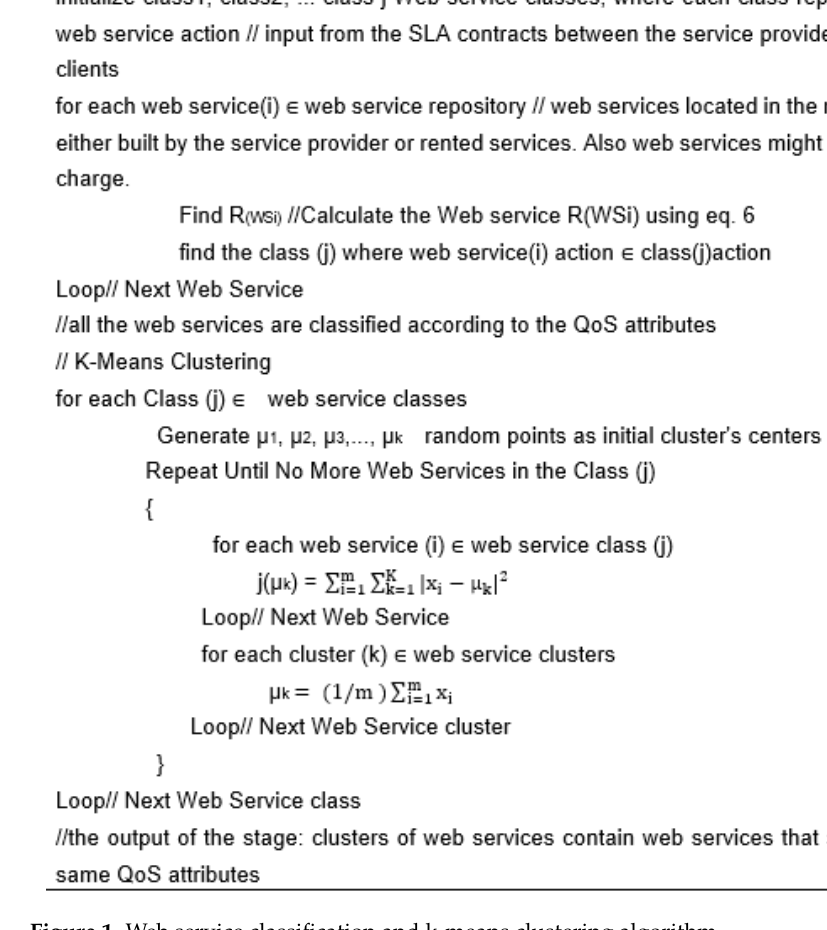
Figure 1. Web service classification and k-means clustering algorithm.